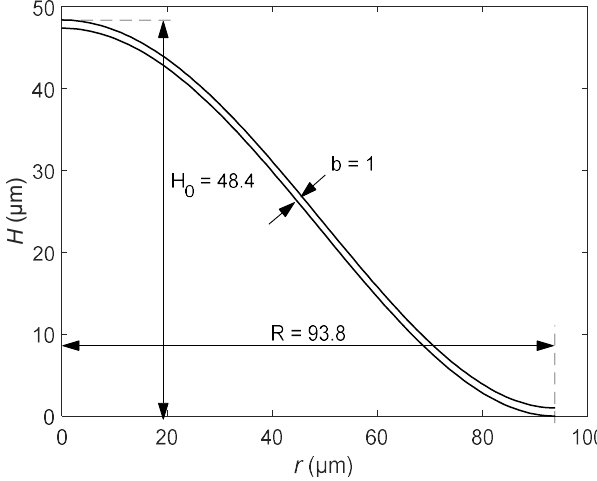
Figure 2. The contour curve of the bionic structure.